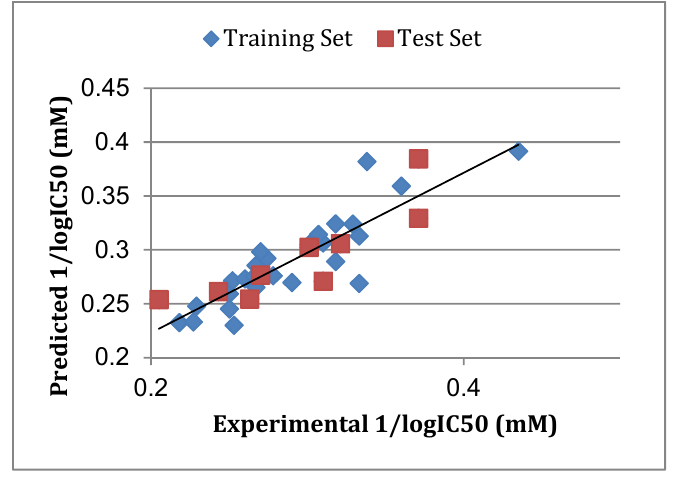
Figure 12. Correlation graph between the experimental 1/log IC50 and predicted